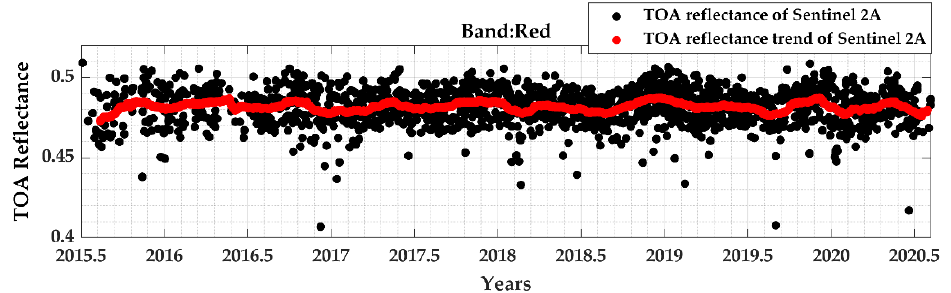
Figure 9. Sentinel 2A trend with the daily acquisition (red dots represent the trend line detected by the Savitzky–Golay filter applied on the black dots, which is the spectral band adjusted factor (SBAF)-corrected and BRDF-normalized TOA reflectance of Sentinel 2A).